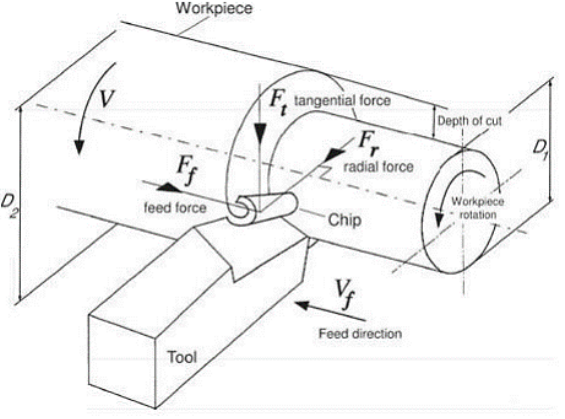
Figure 11. Cutting force on the tool nose in the turning process - Copyright © 2001, American Society of Mechanical Engineers [94].